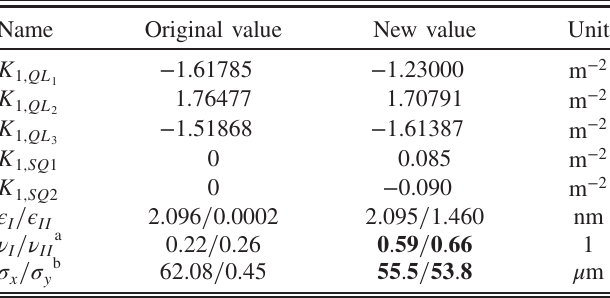
TABLE II. Parameters from flat beam to round beam for off- resonance tune.